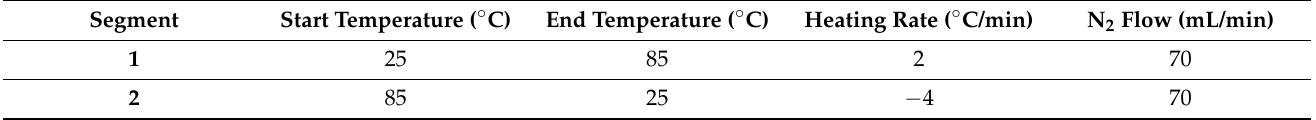
Table 8. (looped once to segment 1) DSC scanning